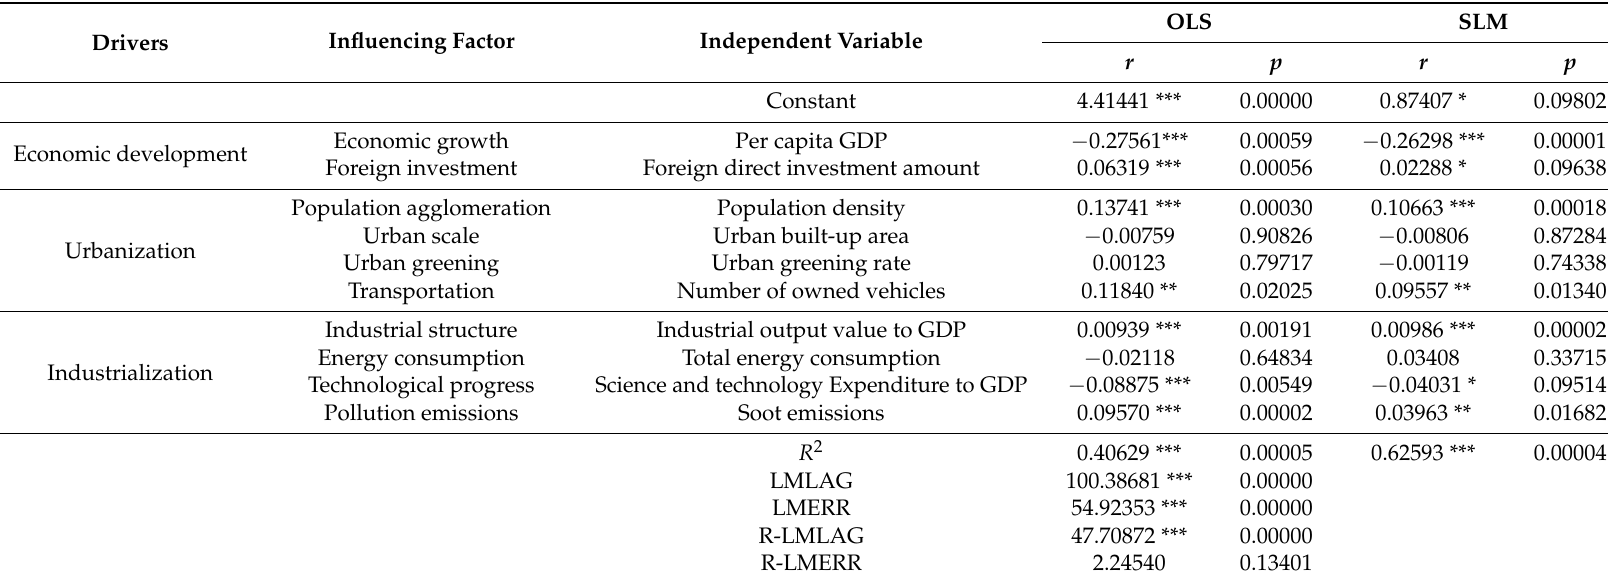
Table 3. Result of the